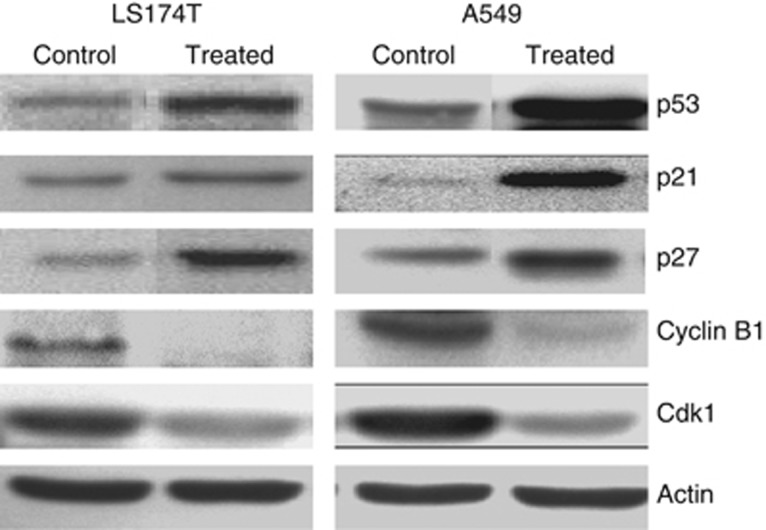
A549 and LS174T cells were analysed by western blot technique. The treatment of p53+ cells (A549 and LS174T) with BPT at IC50 concentration for 24 h resulted in induction of p53, p21CIP1/WAF1 (p21) and p27KIP1 (p27), whereas cyclin B1 and Cdk1 levels were downregulated